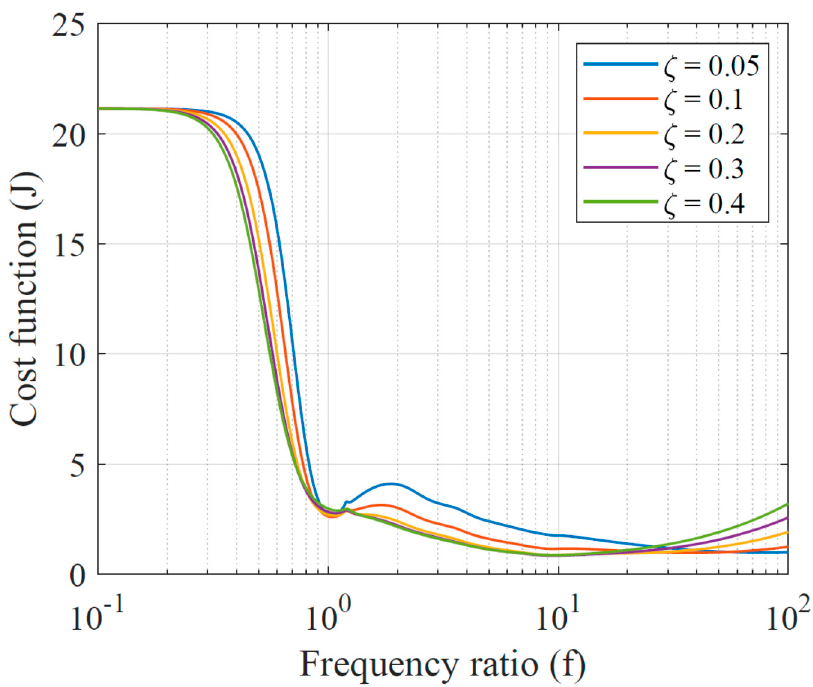
Figure 5. The cost function for the two eight-storey buildings presented in Abdullah et al. [28] as a function of frequency and damping ratios .